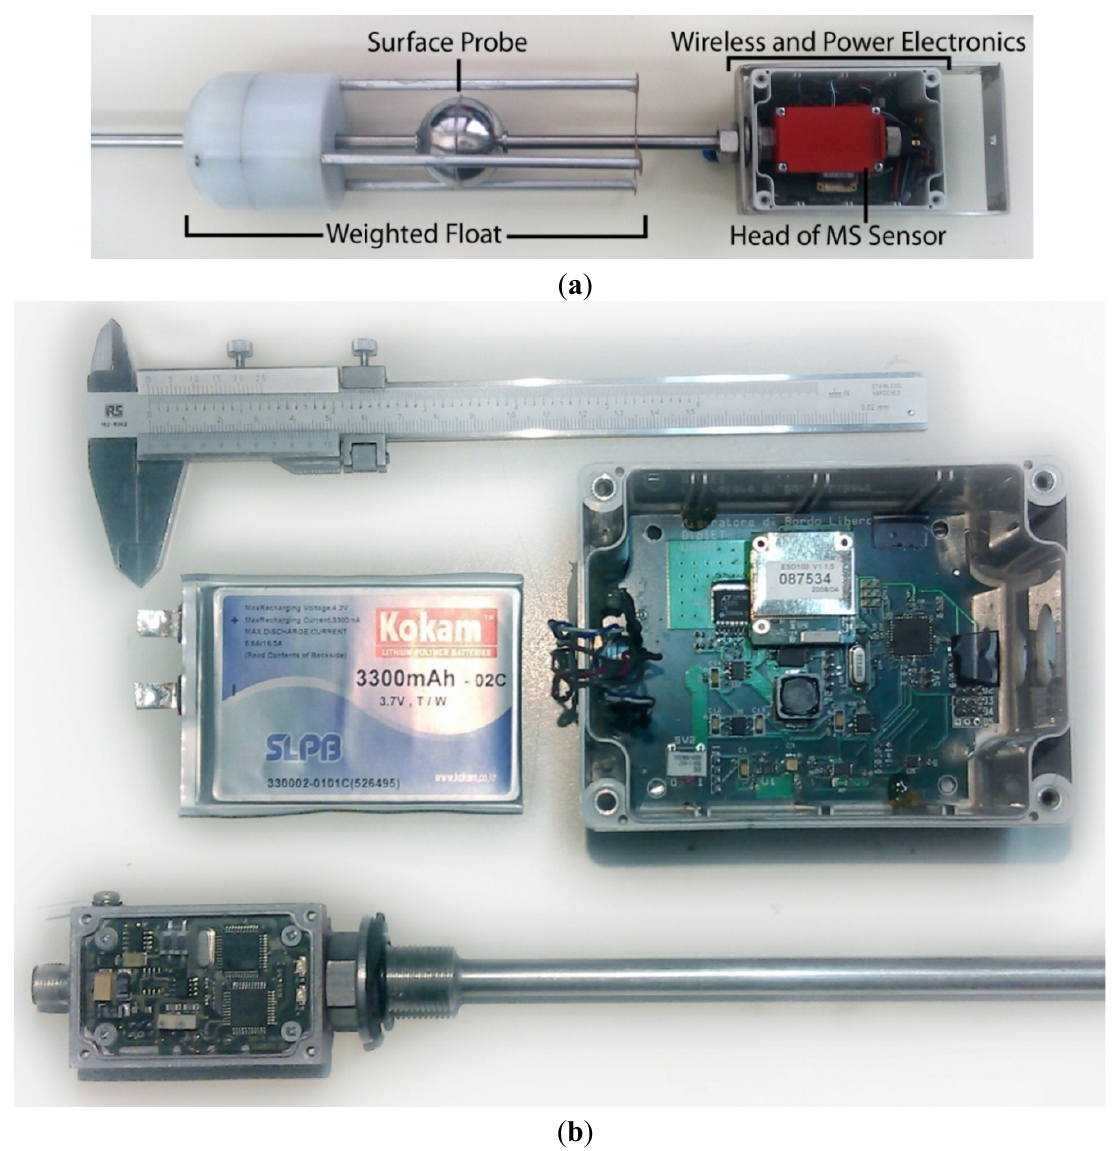
Figure 3. ( a ) Photograph of the complete wireless density meter node. Note the sensor rod with the two probes: the surface floating sphere and the tripod weighted float; ( b ) Density meter electronics consist of the Li-Po battery, the custom wireless board and the MS sensor board, part of the commercial MS liquid level meter customized